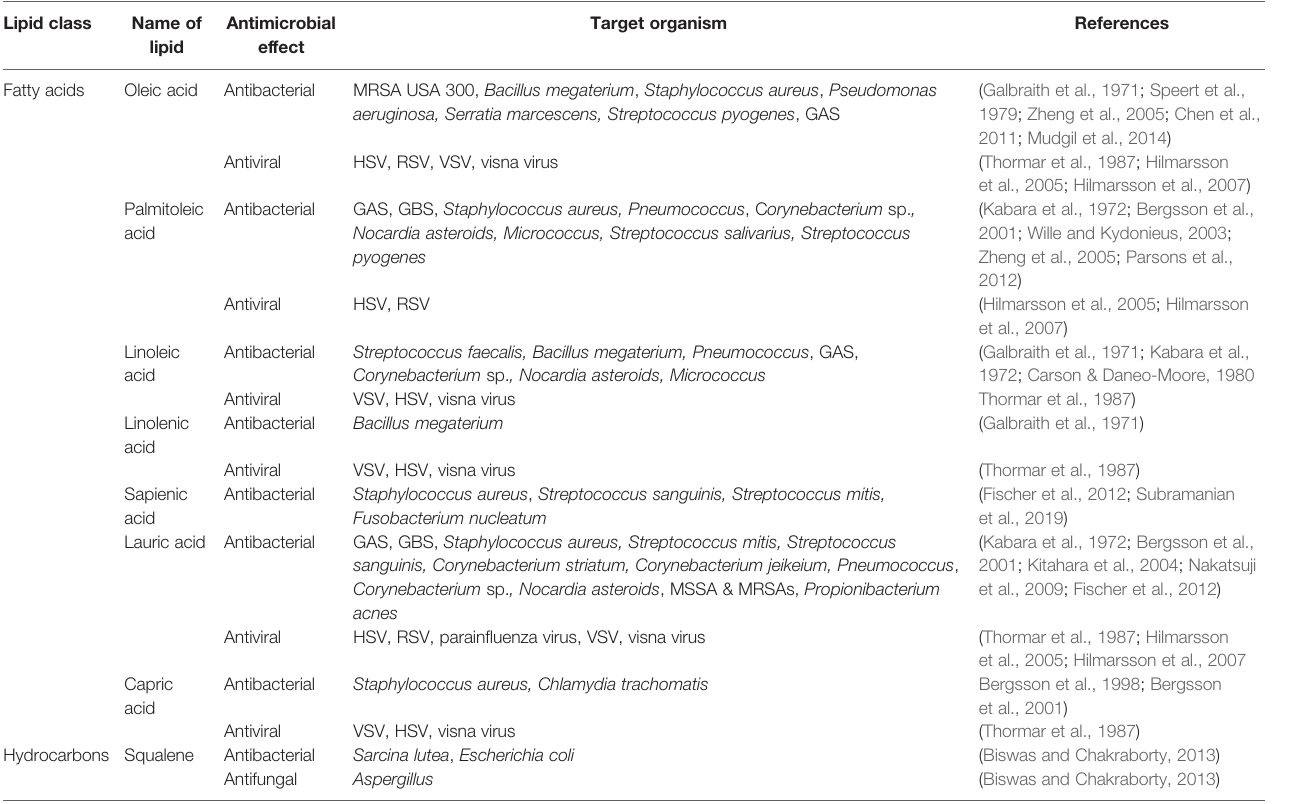
TABLE 2.2 | Antimicrobial potential of lipid classes in tears (free fatty acids and hydrocarbons). Lipid class